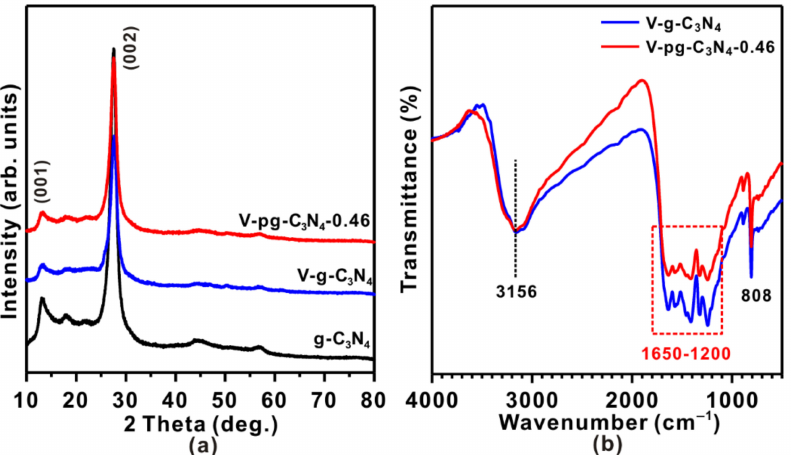
Figure 1. ( a ) X-ray diffraction (XRD) patterns and ( b ) Fourier transform infrared spectroscopy (FT-IR) spectra of as-synthesized